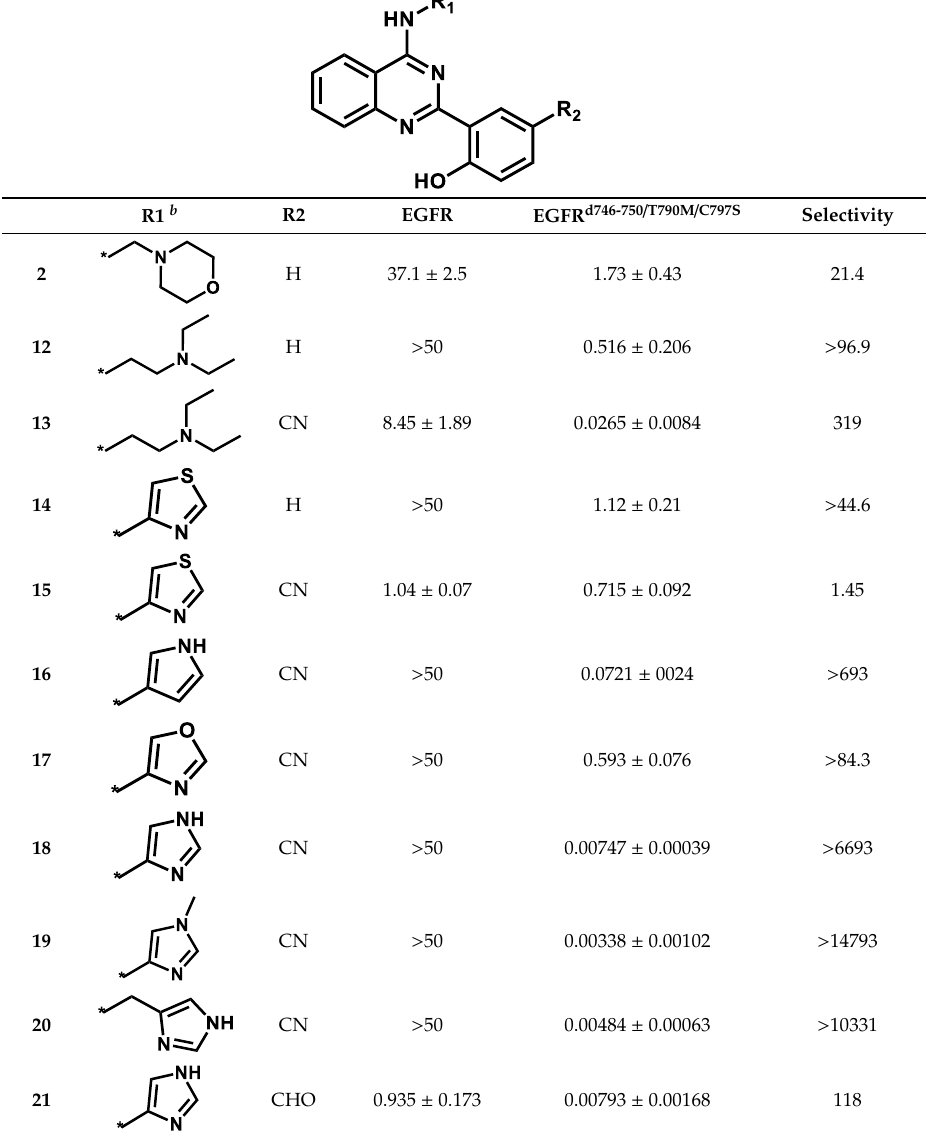
Table 3. Structures and biochemical potencies (IC 50 values in μM) of derivatives of 2 with respect to the d746-750/T790M/C797S mutant and the wild type of EGFR. a.